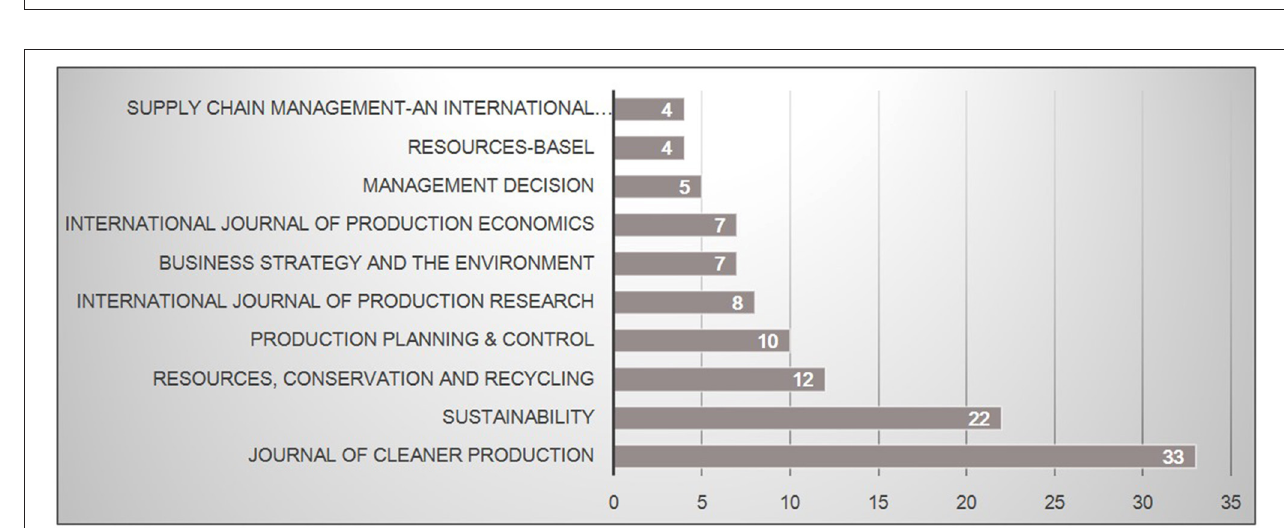
FIGURE 5 | Distribution per year.